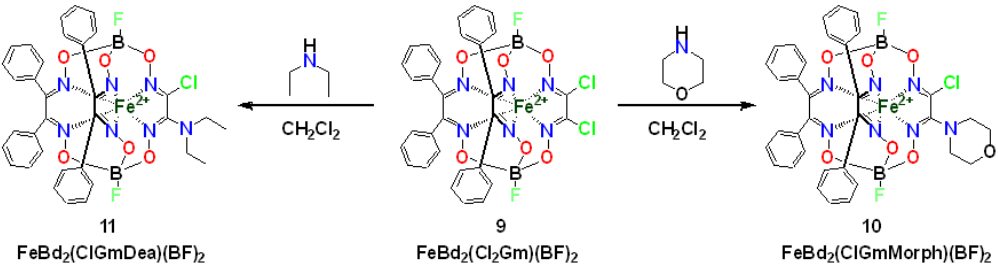
Scheme 2. Synthesis of the monochloromonoamineiron(II)